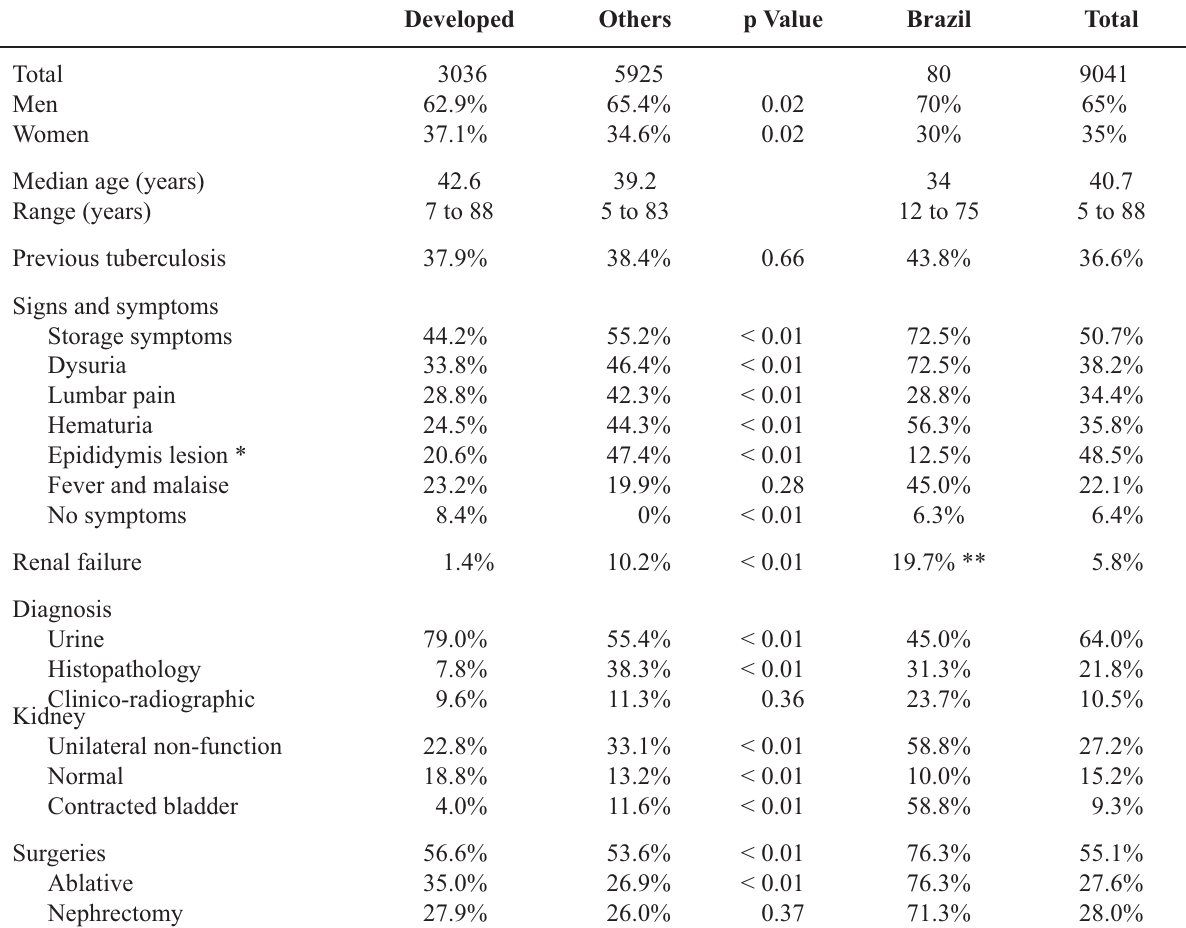
Table 3 – Comparison between 3036 cases of urogenital tuberculosis from developed countries (USA, Europe and Japan) with 5925 cases from other countries (Russia, Latin America and Africa) and 80 cases from